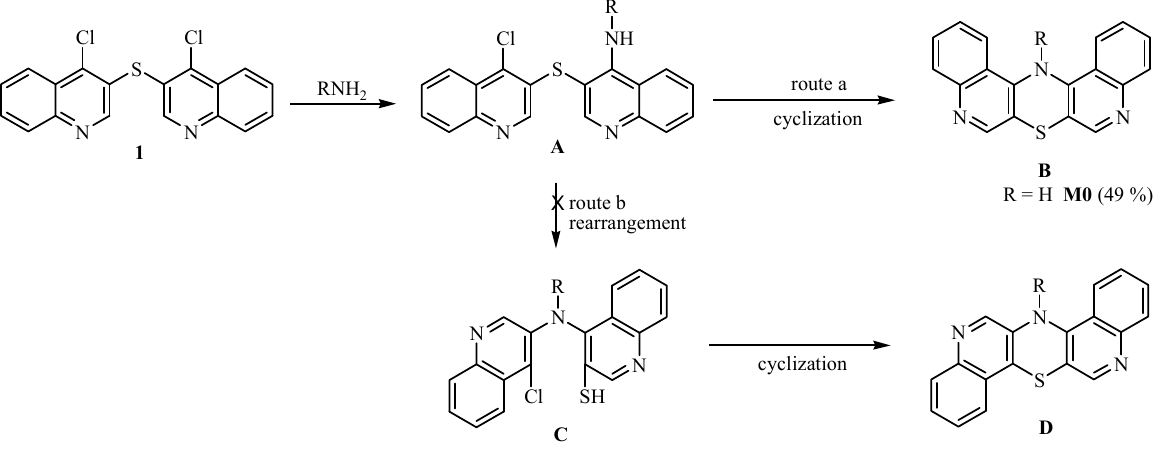
Scheme 1. Possible reaction routes of 4,4 (cid:48) -dichloro-3,3 (cid:48) -diquinolinyl sulfide 1 with amines. Sulfide 1 reacted with dialkylaminoalkylamines, diaminoalkanes, and substituted anilines in hot phenol (180 ◦ C) or in boiling monomethyl ether of diethylene glycol (194 ◦